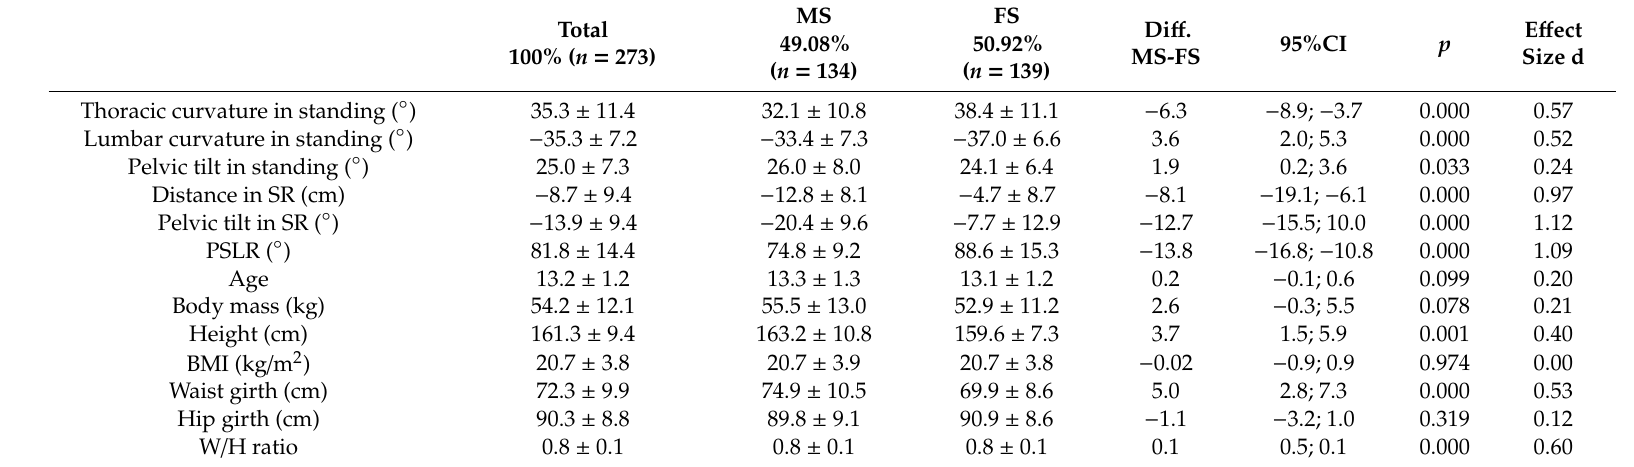
Table 1. Mean values ( ± SD) of curvatures, hamstring extensibility and anthropometric variables and di ff erences between